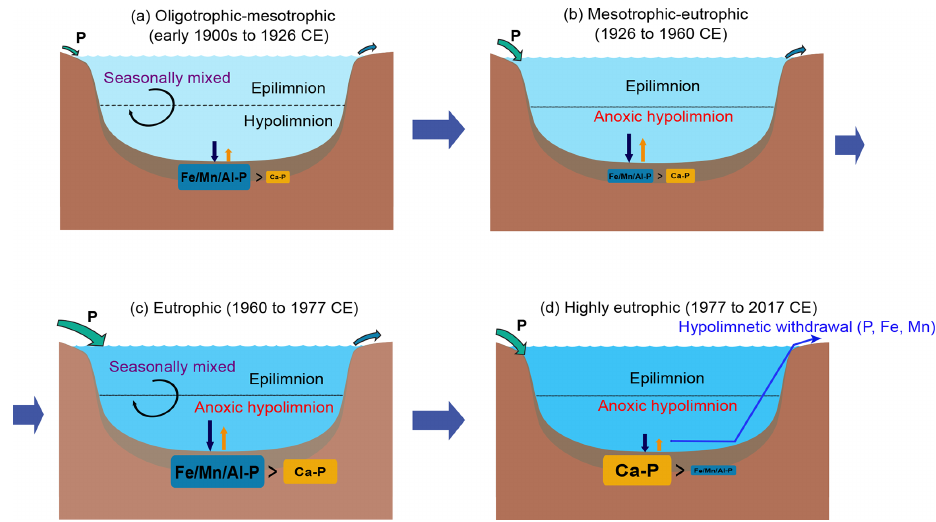
Figure 8. Conceptual diagram, summarizing the inputs/outputs of phosphorus (P), hypolimnetic withdrawal restoration, lake trophic levels, mixing regime, and phosphorus (P) fraction retention in sediments of Lake Burgäschi during four stages/zones. Note that, overall, the illustrated sizes of P fractions (Fe, Mn, Al–P, and Ca–P) among different stages indicate the relative amounts of P fractions in